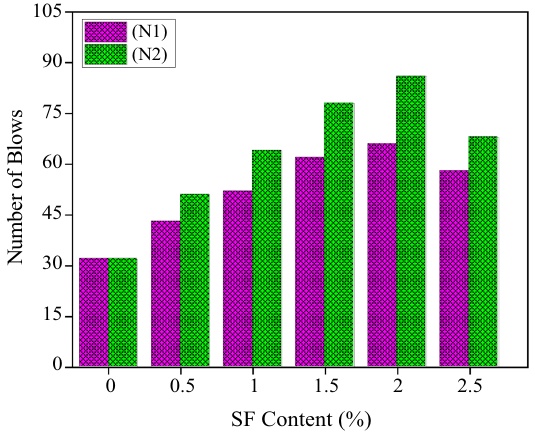
Figure 9: In fl uence of SF content on number of blows of concrete mixed with 3% NS.